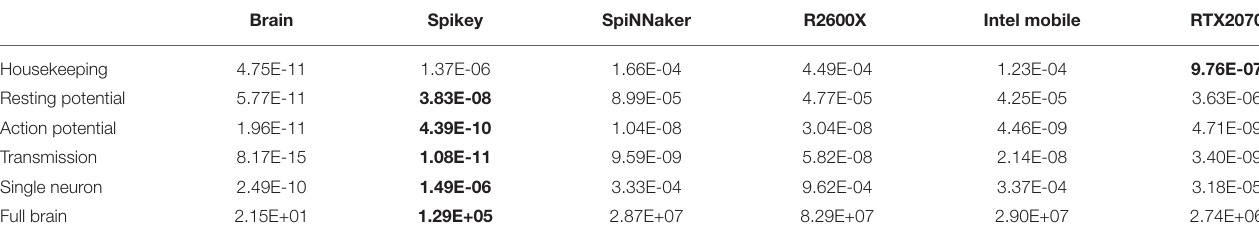
TABLE 5 | Results of the energy model in comparison to the biological